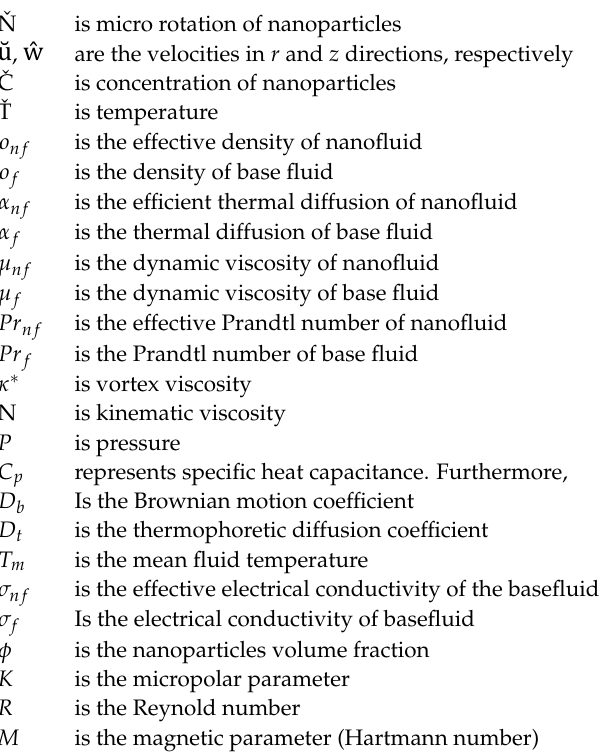
Figure 1. Geometry of the problem